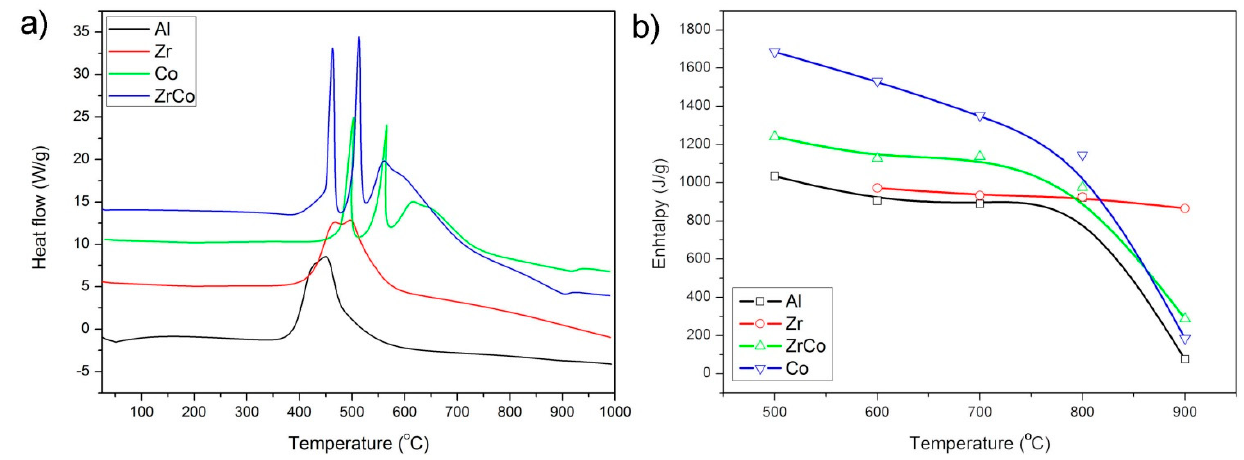
Figure 5. ( a ) Differential scanning calorimetry curves of the materials pyrolyzed at 600 ◦ C; ( b ) oxidation enthalpy. Table 2. Temperatures ( ◦ C) of the decomposition of the materials when heat treated in air atmosphere (n/d stands for none determined). T ( ◦